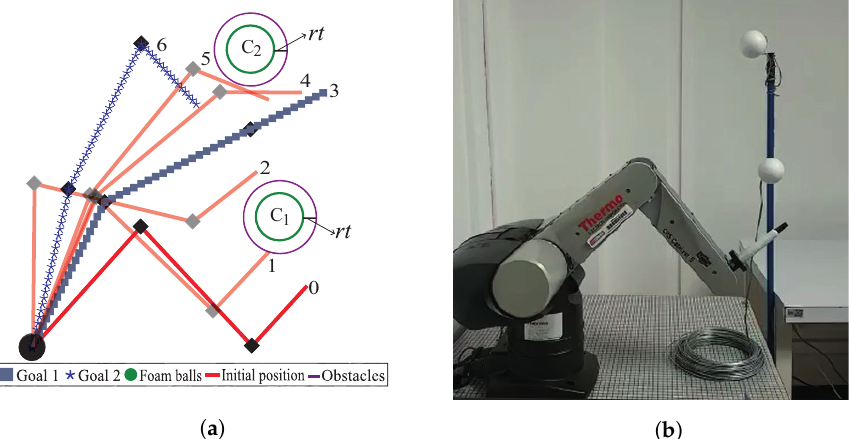
Figure 22. Path planning for the CRS CataLyst-5 robot. ( a ) Robot arm simulation. ( b ) Configuration of the CRS CataLyst-5 robot arm.